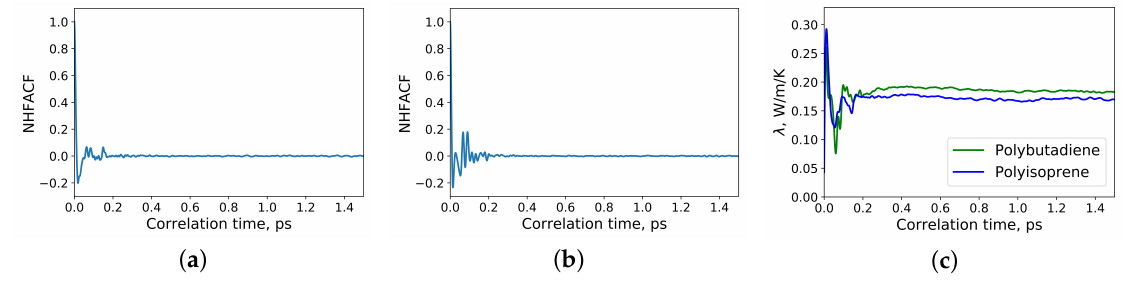
Figure 2. ( a ) Normalized heat flux autocorrelation function (NHFACF) of polyisoprene; ( b ) normalized heat flux autocorrelation function (NHFACF) of polybutadiene; ( c ) thermal conductivities of polyisoprene and polybutadiene at 22 ◦ C and atmospheric pressure.